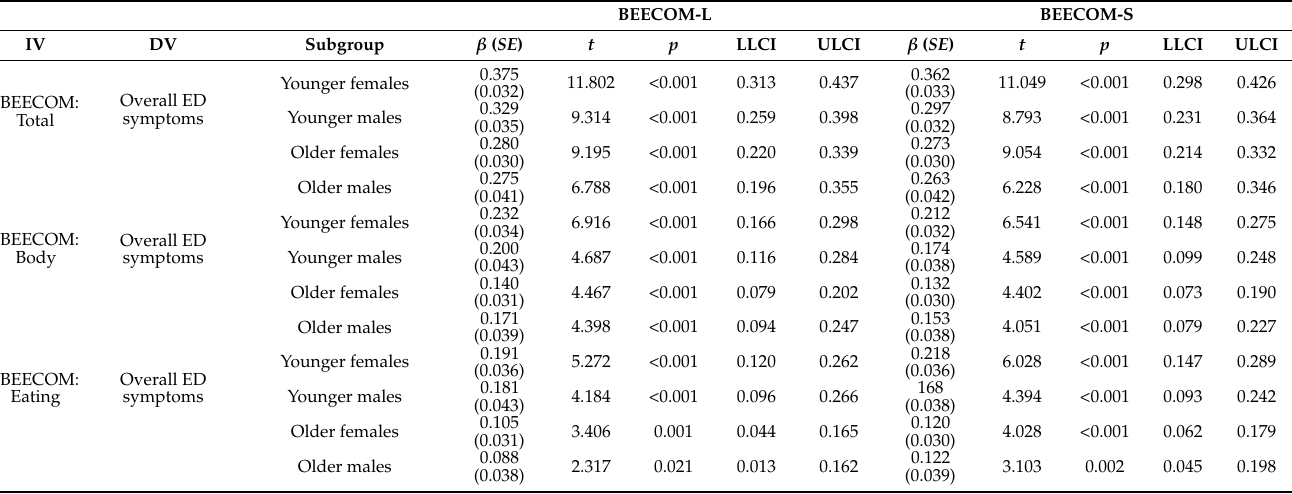
Table 6. Conditional Effects of BEECOM scores on eating disorder outcomes across population